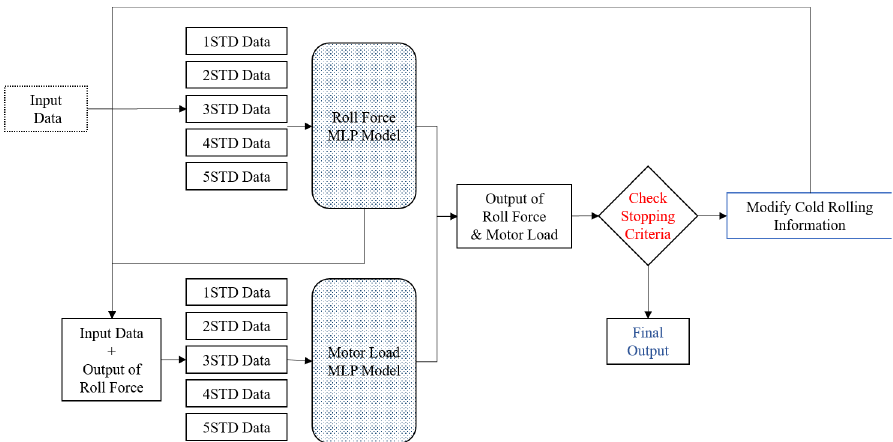
Figure 4. Diagram of our proposed